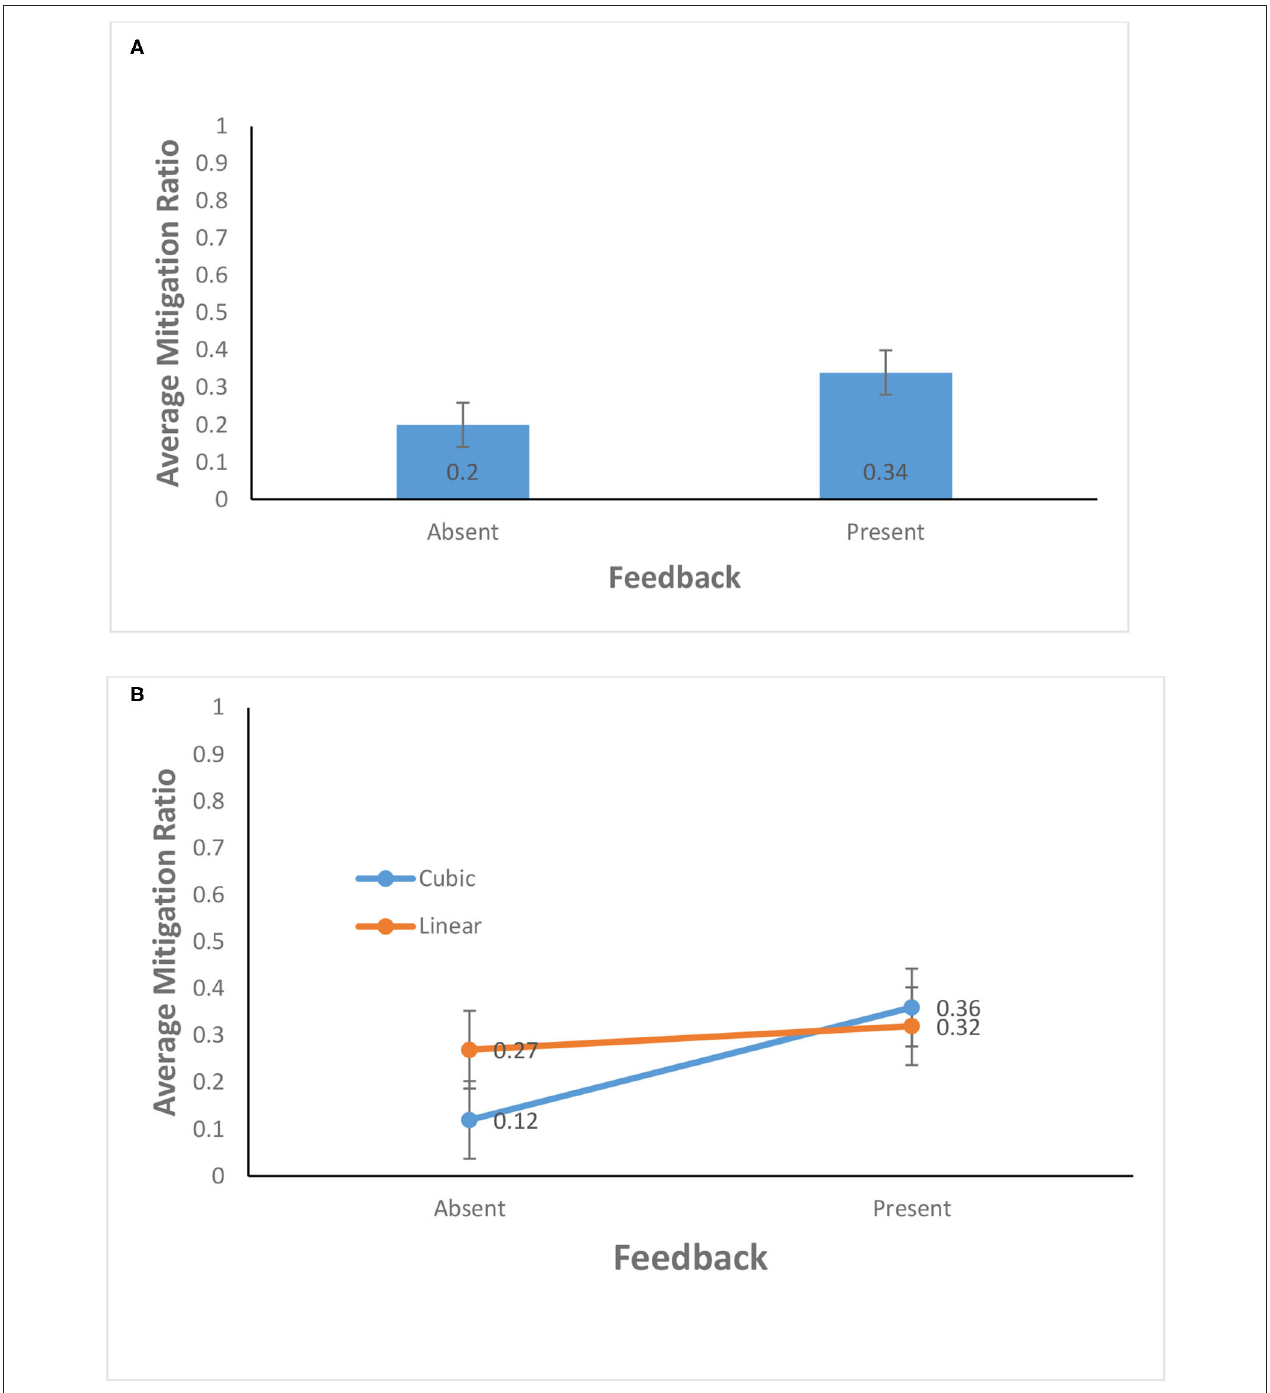
FIGURE 5 | (A) Average mitigation ratio in feedback-present and absent conditions. (B) Average mitigation ratio in cubic and linear probability of climate change and feedback-present or absent conditions. The error bars show 95% CI around the point estimate.